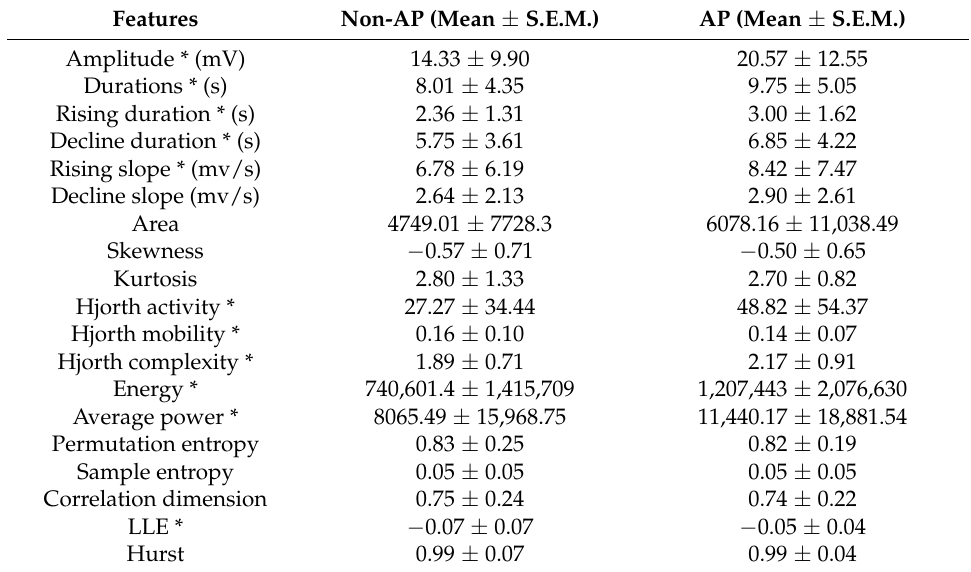
Table 4. T -test for non-AP and AP features.